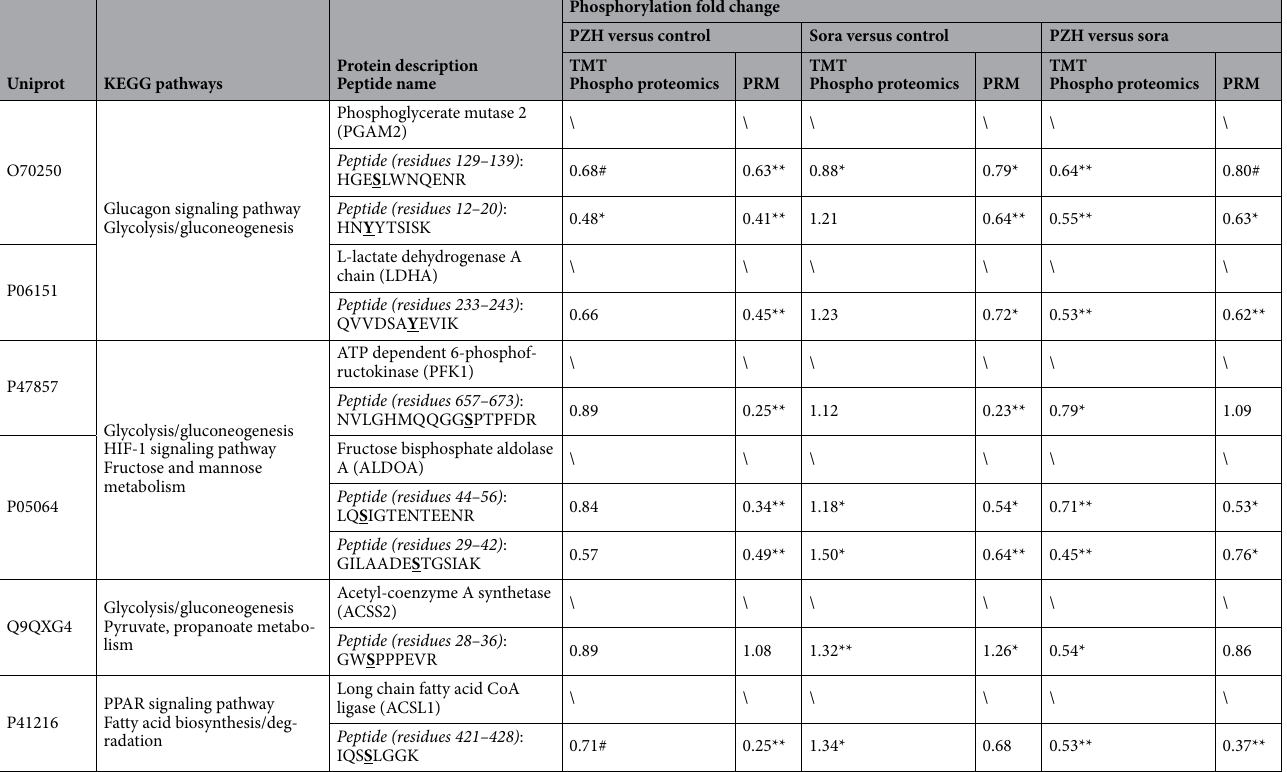
Table 3. Comparisons of differentially expressed phosphorylated peptides related to metabolic pathways treated with PZH and sorafenib from TMT phosphoproteomics and PRM verification. One-way ANOVA, * p < 0.05 versus control group, ** p < 0.01 versus control group. The value greater than 1 indicates up-regulation, less than 1 indicates